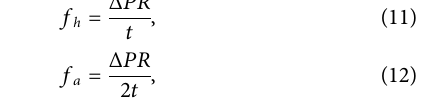
Overpressure calculated by Crowl ’ s equation (Pa)